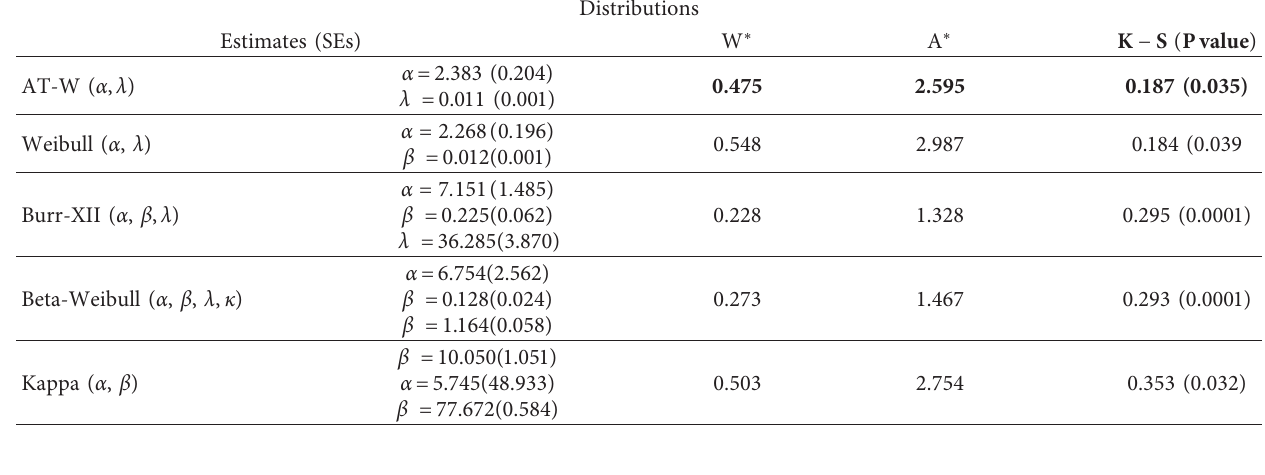
Table 8: MLEs of the proposed model parameters, the goodness-of-fit tests, and the p values (in parenthesis) for Data Set I.